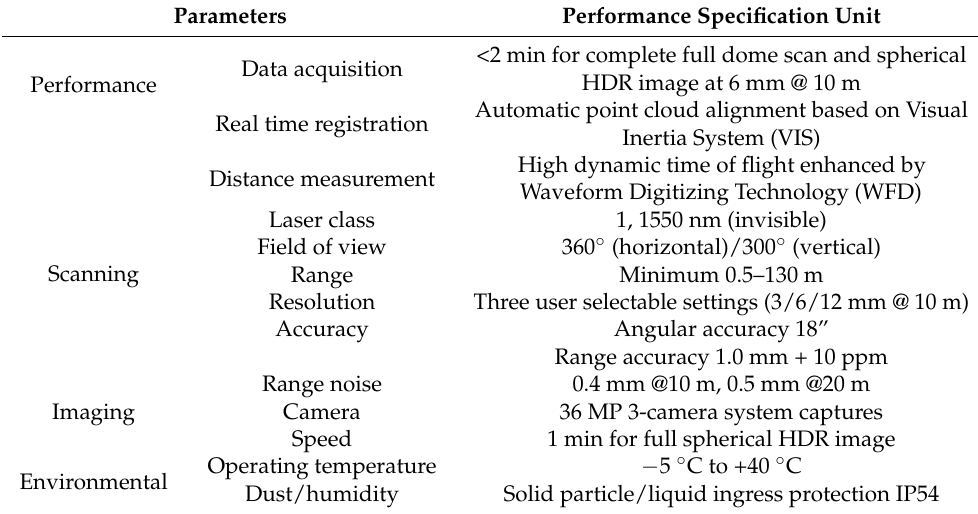
Table 2. A detailed specification of the 3D scanner